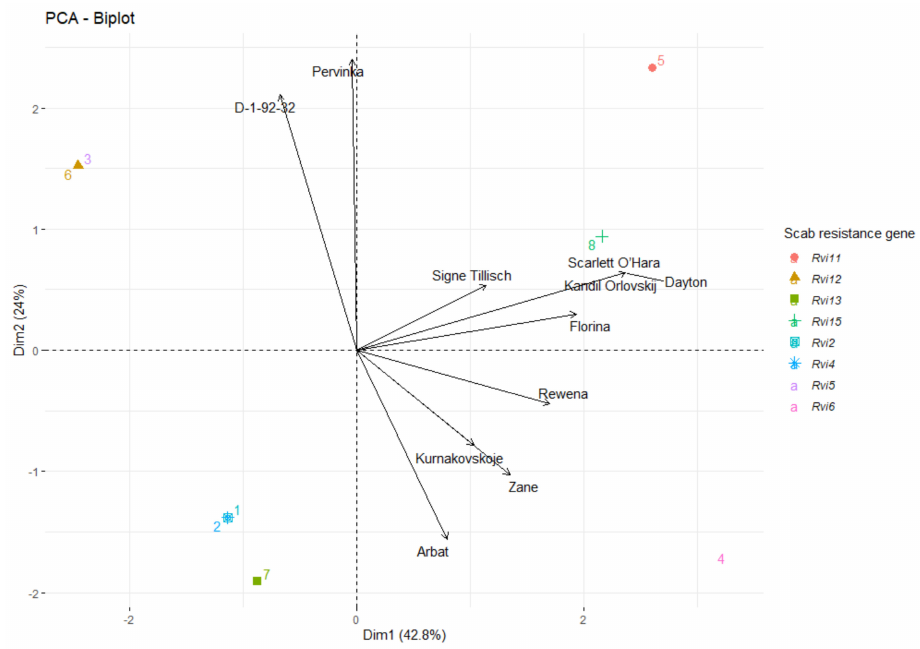
Figure 7. PCA analysis of genetic relatedness of parental genotypes using specific fragments of the scab resistance